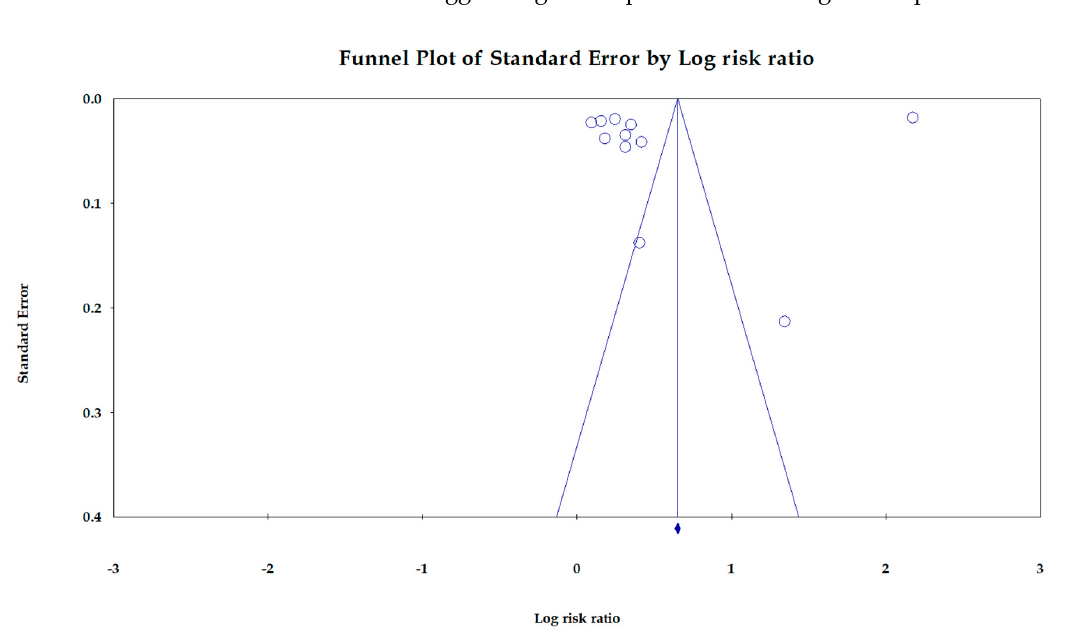
Publication Bias : Figure 3 shows the funnel plot of the association between PPI use and the risk of CKD. This Egger’s regression plot indicates no significant publication bias ( p = 0.53).